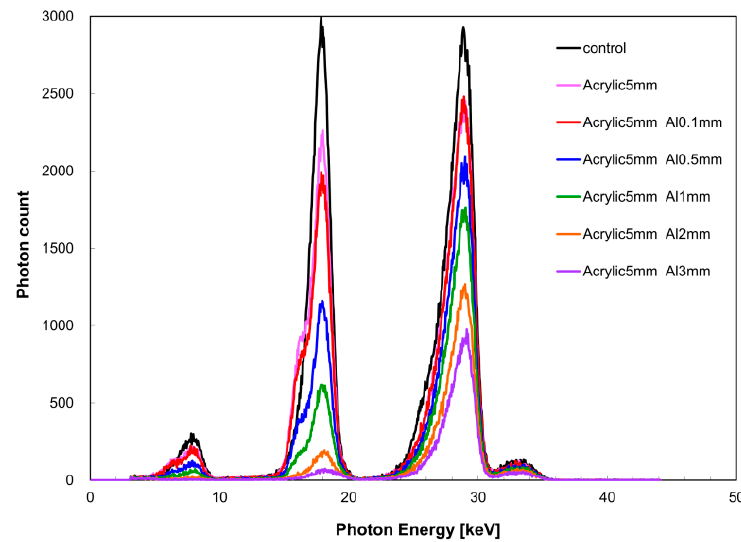
Figure 8. X-ray spectrum in aluminum density evaluation by dual-energy X-ray absorptiometry. Table 1. Aluminum density calculated from quasi-monochromatic, dual-energy X-ray spectrum. Aluminum